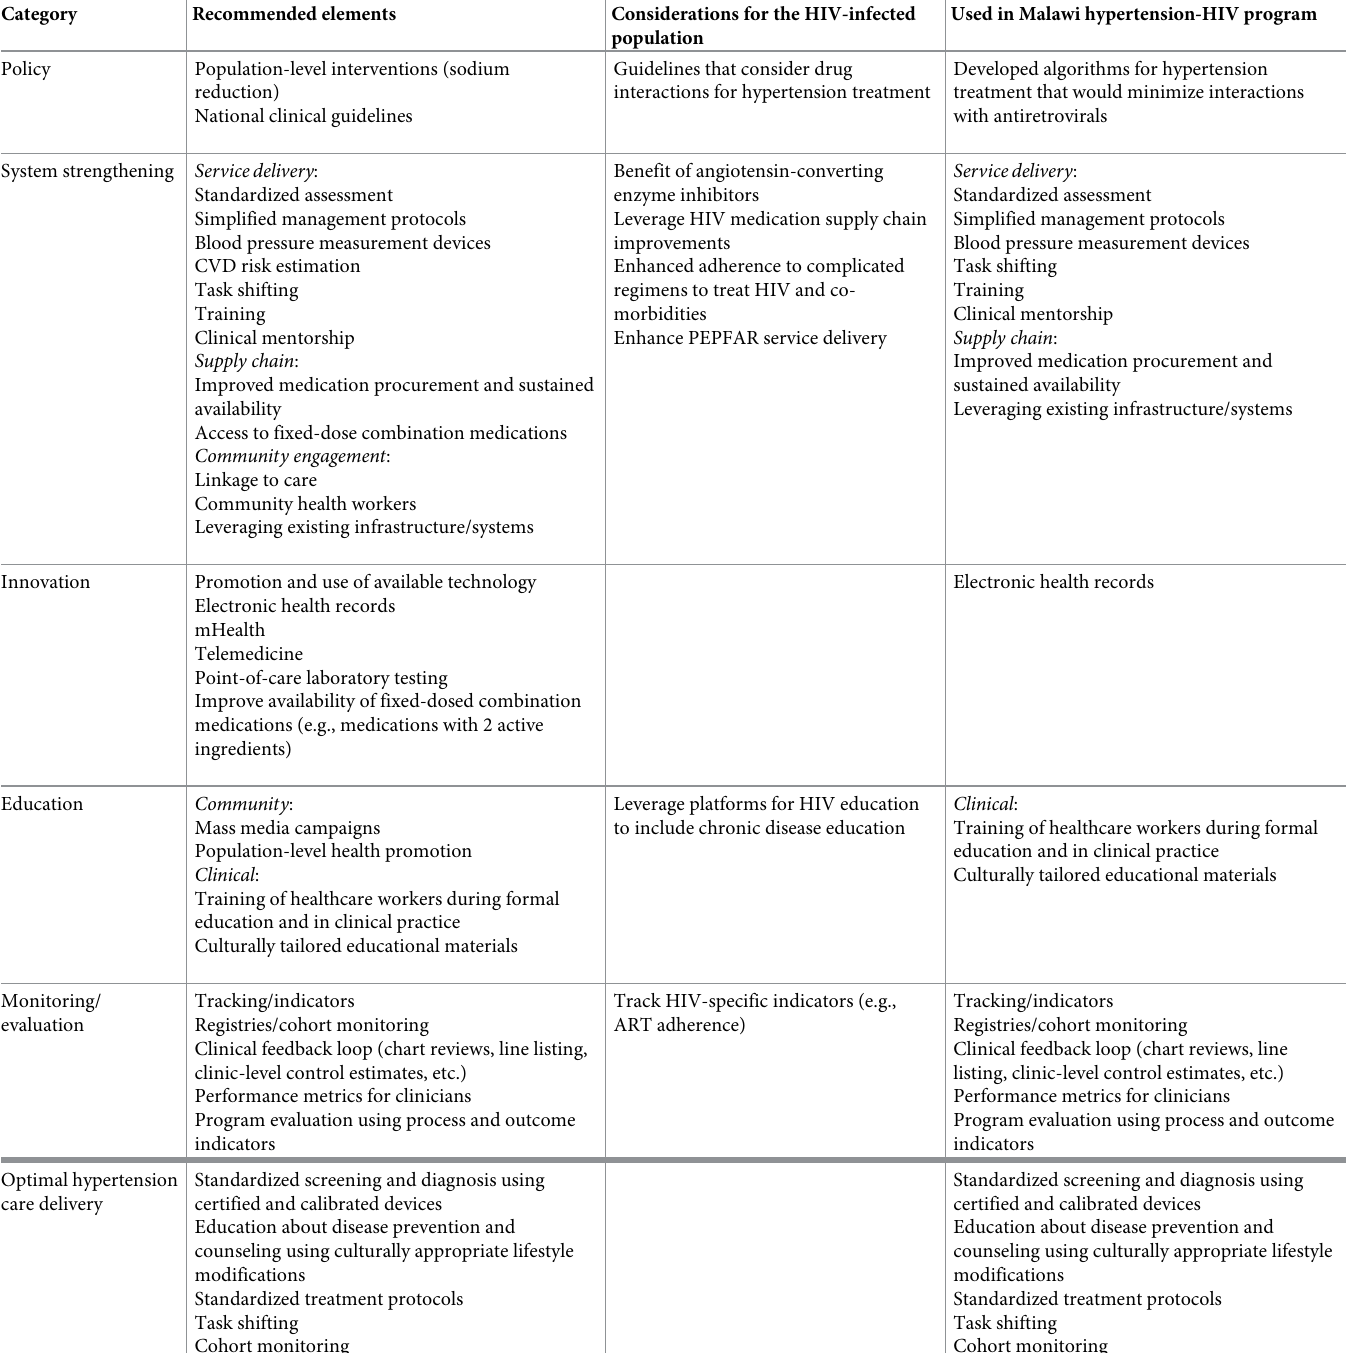
Table 1. Recommended elements for successful hypertension and human immunodeficiency virus (HIV) management integration.